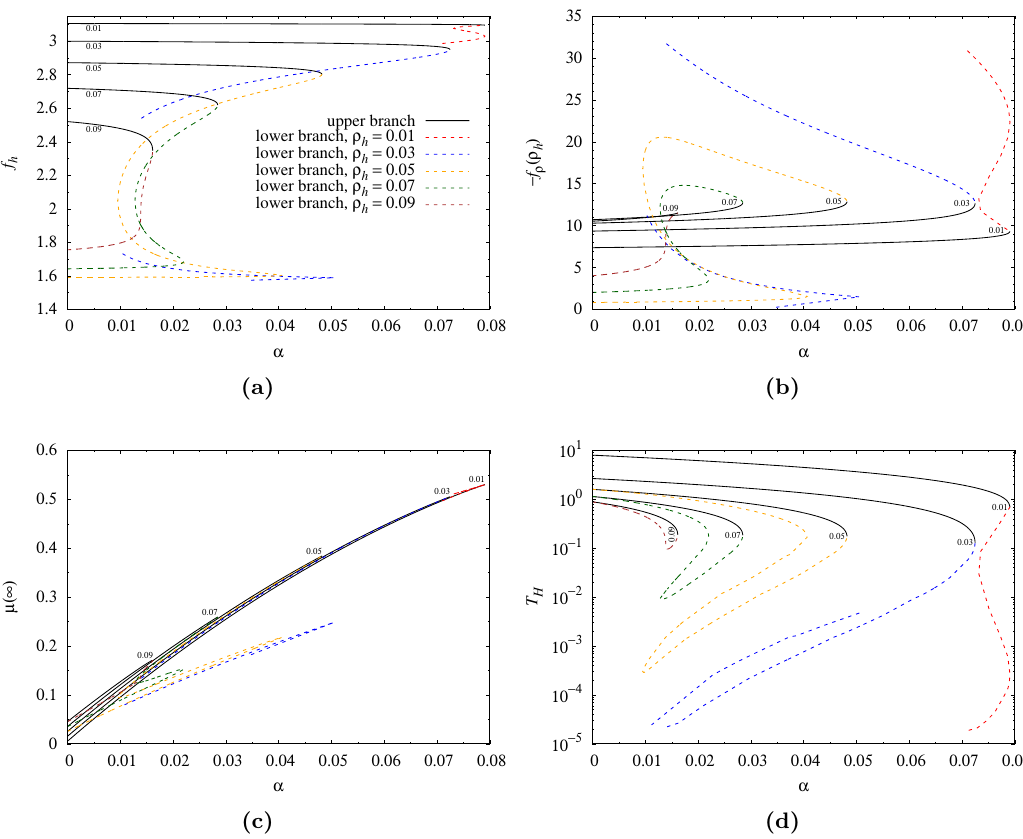
Figure 21 . Upper (black solid lines) and lower (red dashed lines) branches of solutions in the 2+12 model: (a) the value of the pro(cid:12)le function at the horizon, f h ; (b) the derivative of the pro(cid:12)le function at the horizon, f (cid:26) ( (cid:26) h ); (c) the ADM mass, (cid:22) ( 1 ); (d) the Hawking temperature T H , all as functions of the gravitational coupling, (cid:11) . The numbers on the (cid:12)gures indicate the di(cid:11)erent values of (cid:26) h = 0 : 01 ; 0 : 03 ; : : : ; 0 : 09. The lower branches are colored di(cid:11)erently for each horizon radius, see the legend in panel